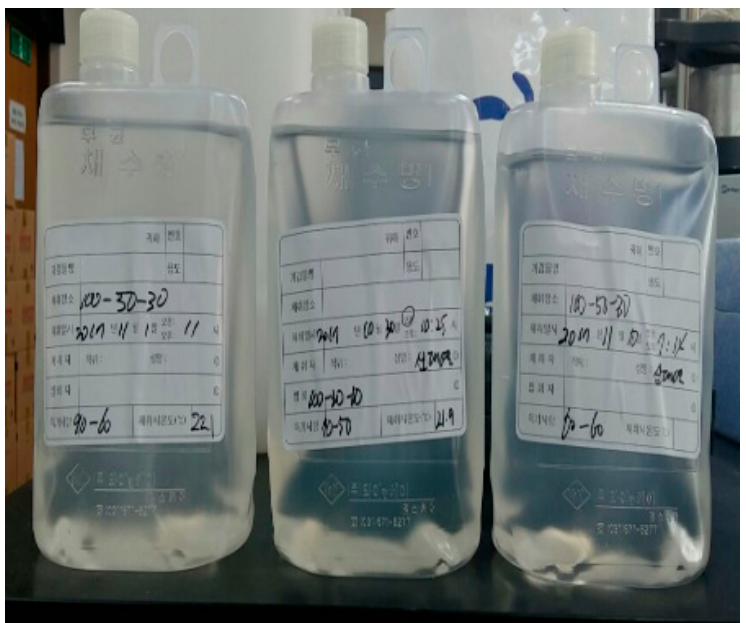
Figure 2. A picture of effluent water.